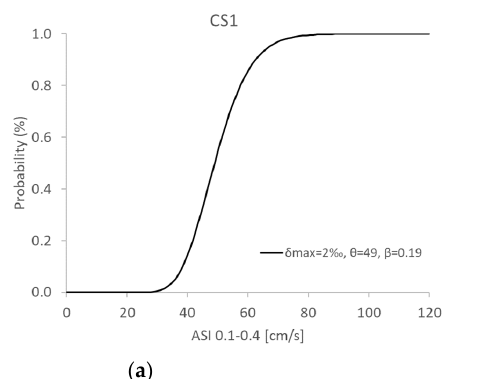
Figure 15. Fragility curves in PGA scale ( a ) CS1 and ( b ) CS2.